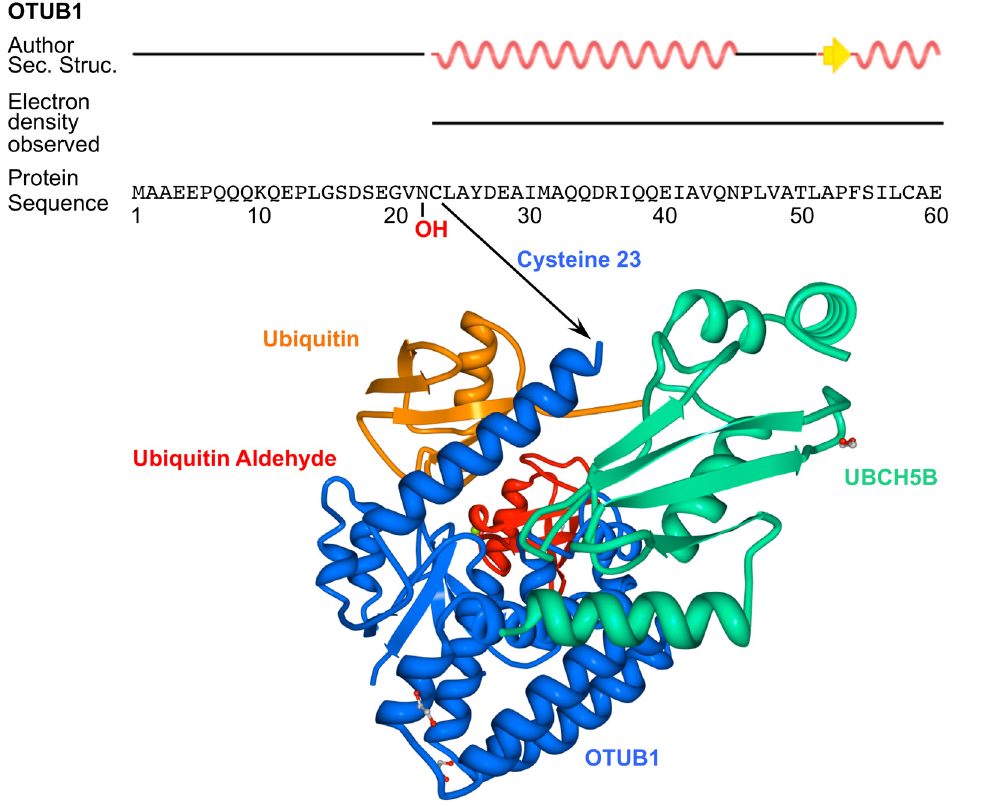
Fig 7. Crystal structure of OTUB1 in complex with UBCH5B, ubiquitin and ubiquitin aldehyde. Indication of the position of the FIH-targeted asparagine 22 of OTUB1 in its secondary, tertiary, and quarternary structure. The image depicts the secondary structure annotation and the crystal structure of a human/ Caenorhabditis elegans OTUB1 hybrid (containing the N-terminal 45 amino acids of human OTUB1 and the OTU domain of C . elegans OTUB1) in complex with human UBCH5B (containing a C85S mutation), human ubiquitin and human ubiquitin aldehyde. Structural two-dimensional images and data of the three-dimensional structures were downloaded from RCSB PDB (http://www.rcsb.org/) (PDB ID: 4LDT) and the three-dimensional image was created using Protein Workshop [48,49]. The original data was published by Wiener et al., 2013 [26]. Electron density was not observed for amino acids 1 – 22 of the N- terminus because these residues were disordered. Author Sec. Struc. = Secondary structure annotation approved by depositor of